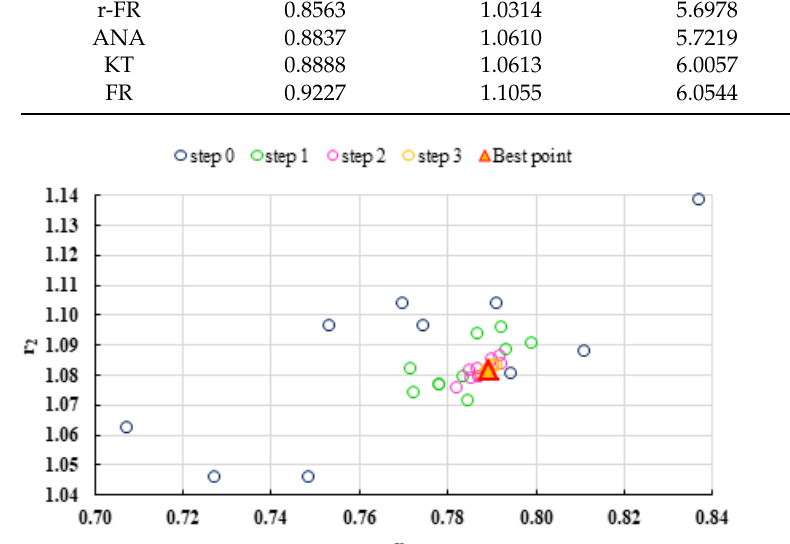
Figure 18. The JCR of analyzed methods for reactivity ratios calculation for HC3 imposed condition.